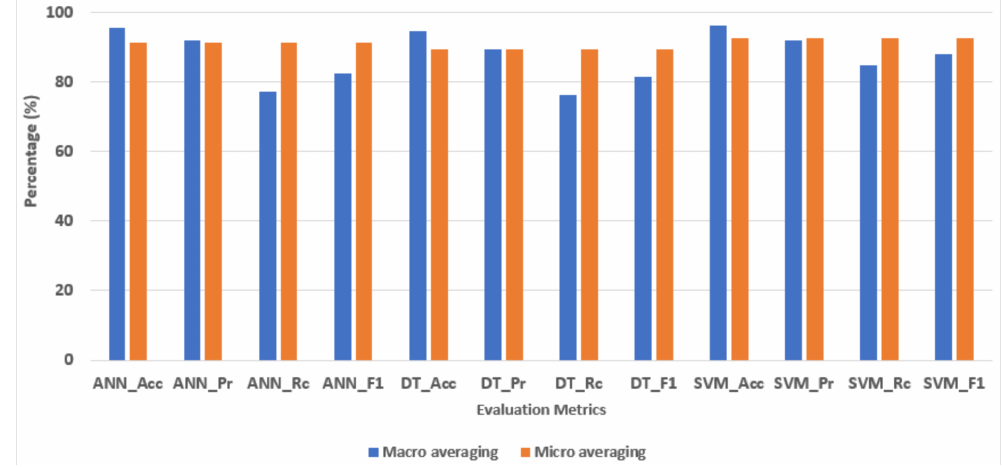
Figure 5. Macro average percentage vs. micro average